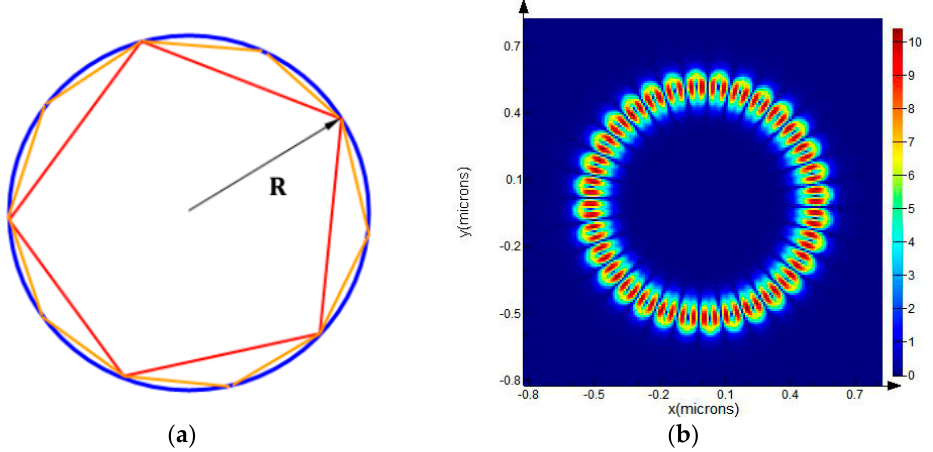
Figure 3. ( a ) Geometric schematic of the whispering-gallery mode (WGM) resonance; ( b ) Electromagnetic field distribution of the WGM resonance.